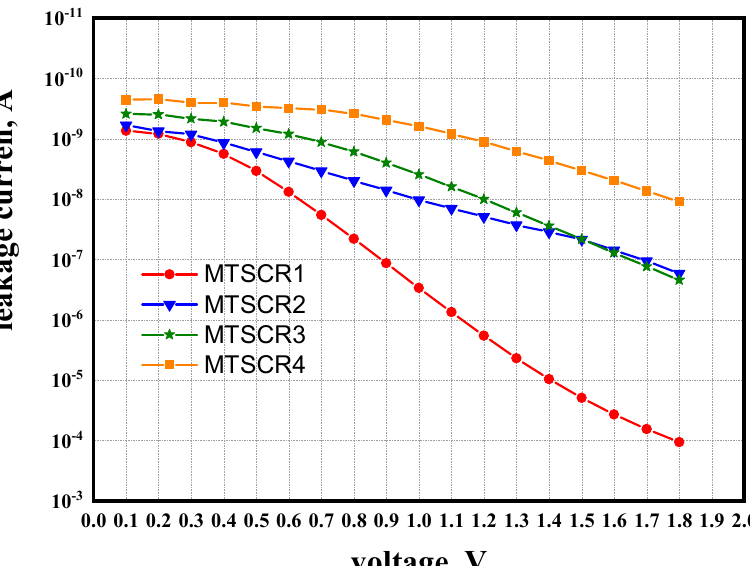
Figure 4. DC sweep of MTSCR1, MTSCR2, MTSCR3, and MTSCR4 at 25 °C.